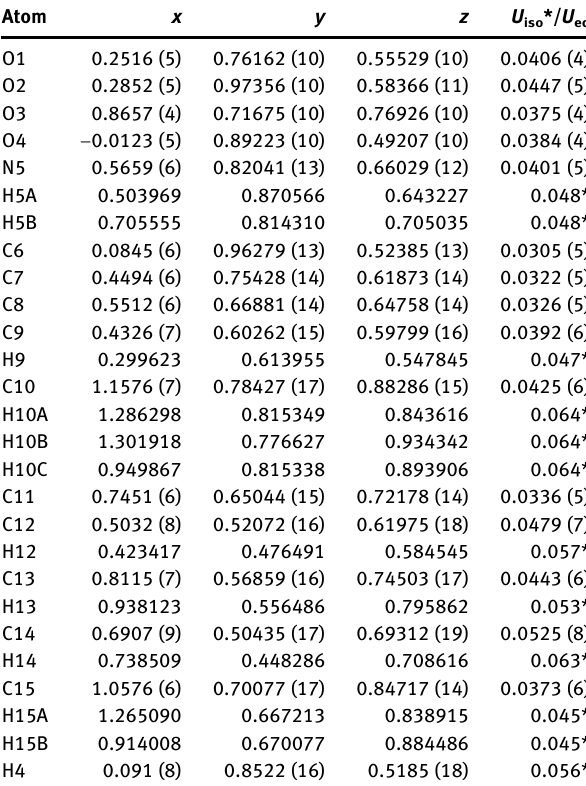
Table  : Fractional atomic coordinates and isotropic or equivalent isotropic displacement parameters (Å 